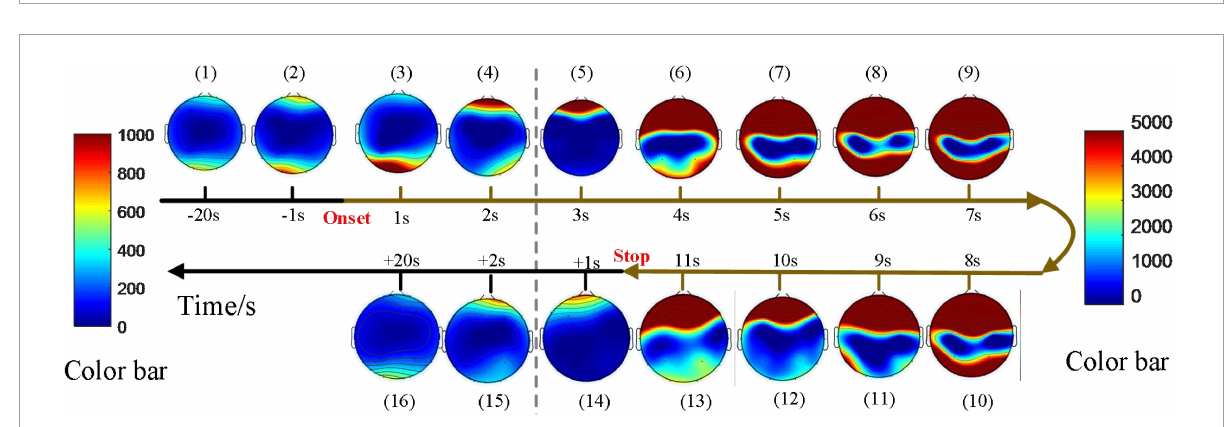
FIGURE4 An example of the topographic distribution of the EEG power. Color bar scale of the six topographies on the left of the gray dotted line is 0–1,000 and the scale of the rest topographies on the right is 0–5000 due to an enormous increase in PSD during seizures. –20 s: The average of PSD in 20 s before seizure start; +20 s: The average of PSD in 20 s after seizure stopped. There was a process of first increasing and then decreasing in the spatial distribution of PSD for all